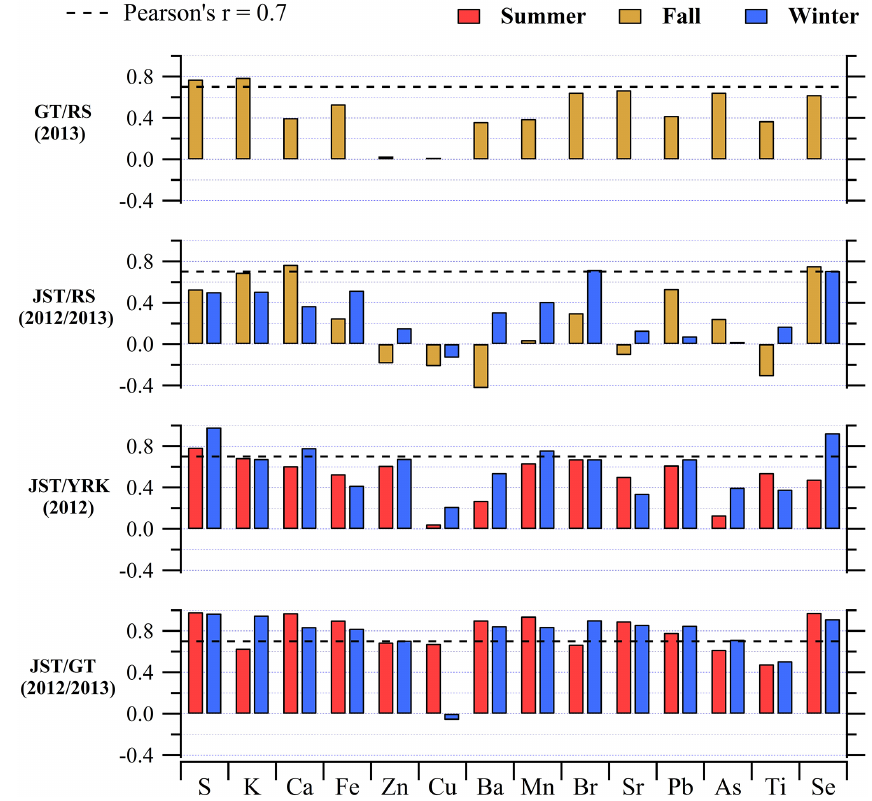
Figure 6. Correlations (Pearson’s r ) between paired sites for various water-soluble elements in Georgia (JST, RS, GT, and YRK).